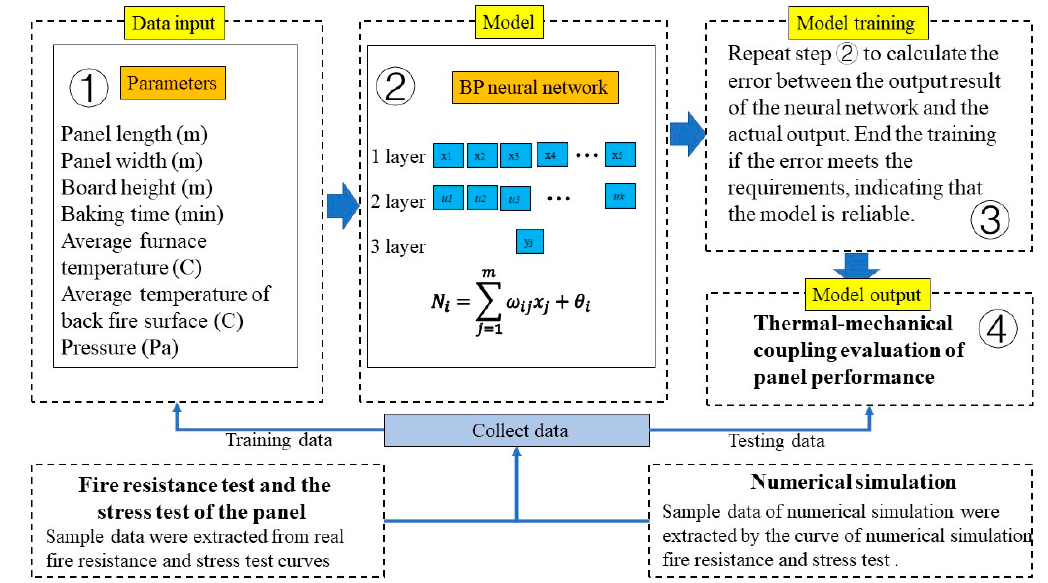
Figure 2. Research process of the BP neural network model in the thermal–mechanical coupling evaluation of prefabricated substation panel performance. x 1 , x 2 , …, x 5 , respectively, represents input layer parameters of neural network; u 1 , u 2 , …, u k represent hidden layer parameters of the neural network, respectively; y j represents output layer parameters of neural network; N i represents output results of neural network; ω represents weights of neural network and θ represents thresholds of neural network.